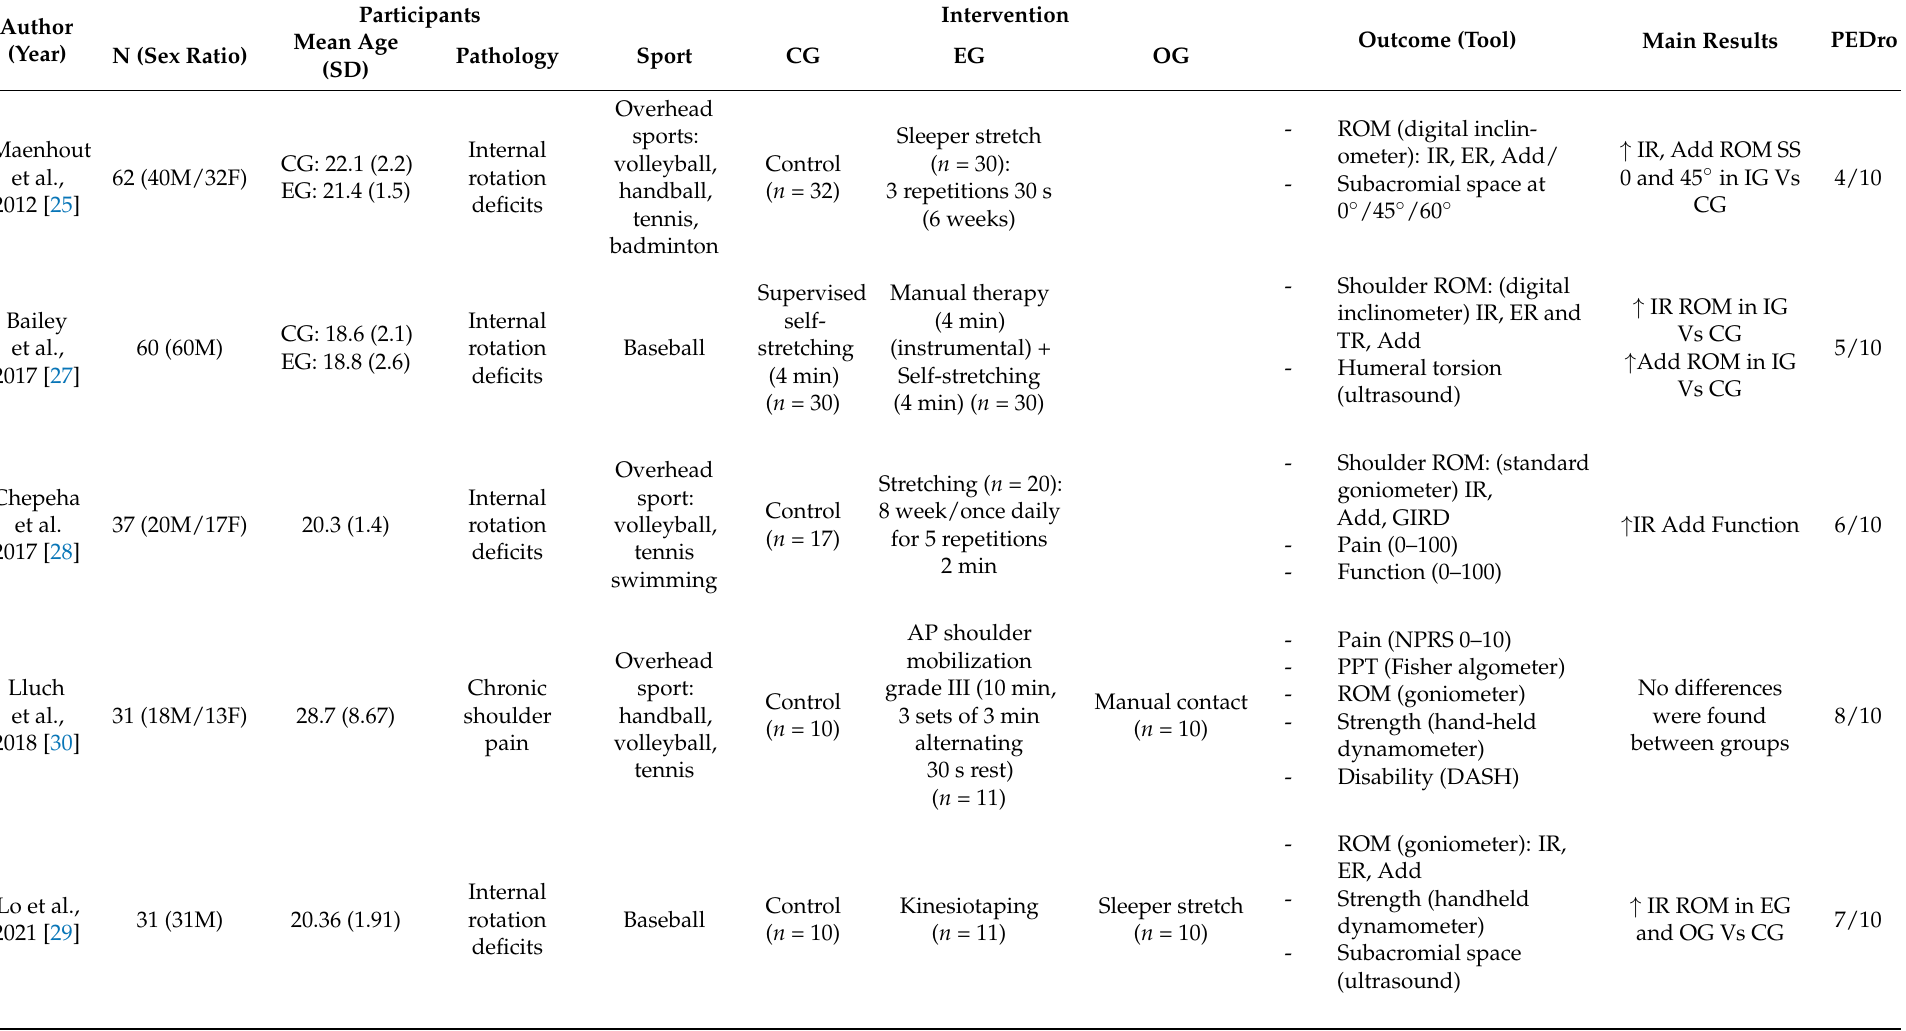
Table 1. Characteristics of included